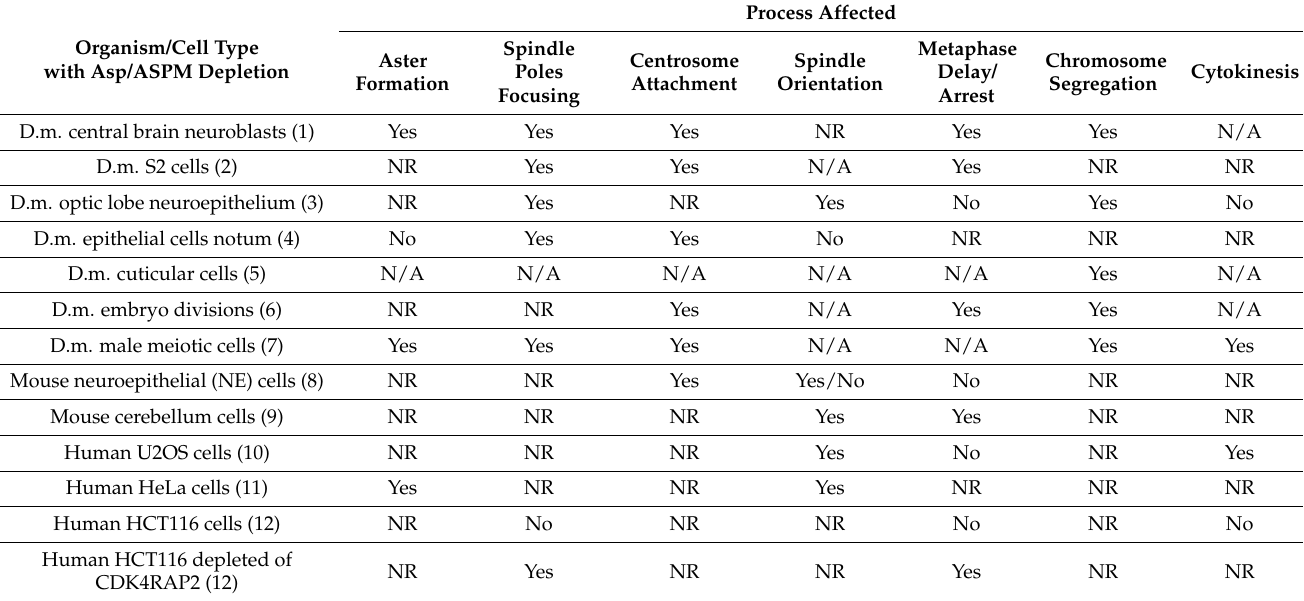
Table 1. Mitotic processes affected by downregulation of the asp / Aspm / ASPM orthologs.